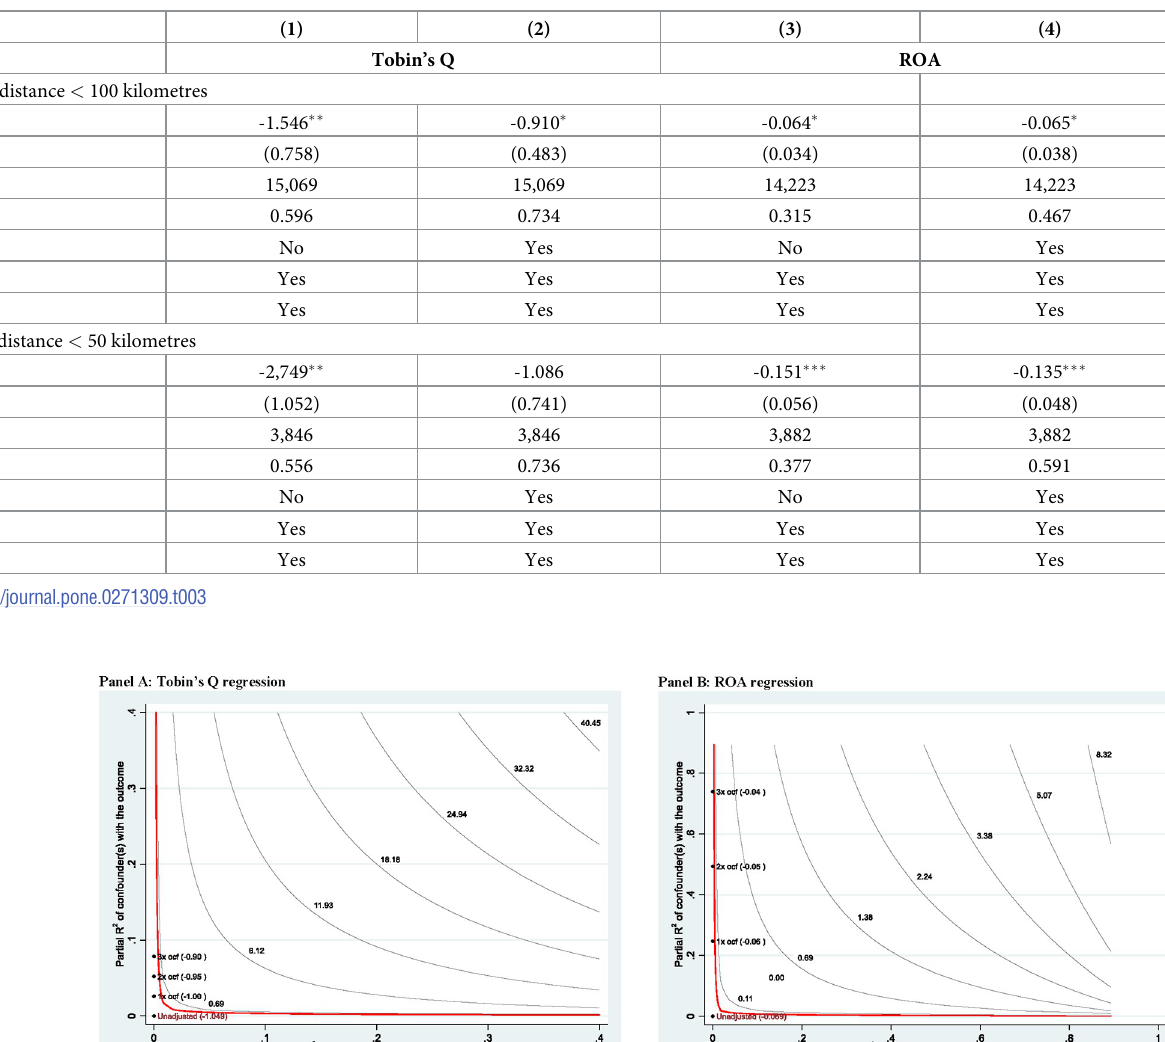
Table 3. Regression results using matched samples. This table reports the results on the effects of flooding on firm performance using the matched sample. To construct the matched sample, we first define treatment firms as firms exposed to flooding in a year during our sample period. We then match each treatment firm with a control firm that is not exposed to flooding in that year and is located in the same province, operating in the same industry (2-digit industry classification by the China Securities Regulatory Commission), and having the closest total assets as the treatment firm. We also require the matched pair of treatment and control firms to be located very close to each other, with the geographic distance being less than 100 kilometres or 50 kilometres, so that they are likely to face very similar local economic conditions and crisis management abilities. In Panel A, we require the geographic distance between the matched treatment and control firms to be less than 100 kilometres. In Panel B, we fur- ther restrict the geographic distance to be less than 50 kilometres. Control variables used in Table 2 are included in columns 2 and 4. Variable definitions are in Table A1 in the S1 Appendix. Robust standard errors are clustered at the city-year level and reported in parentheses. � , �� and ��� indicate the significance levels at 10%, 5% and 1%, respectively.